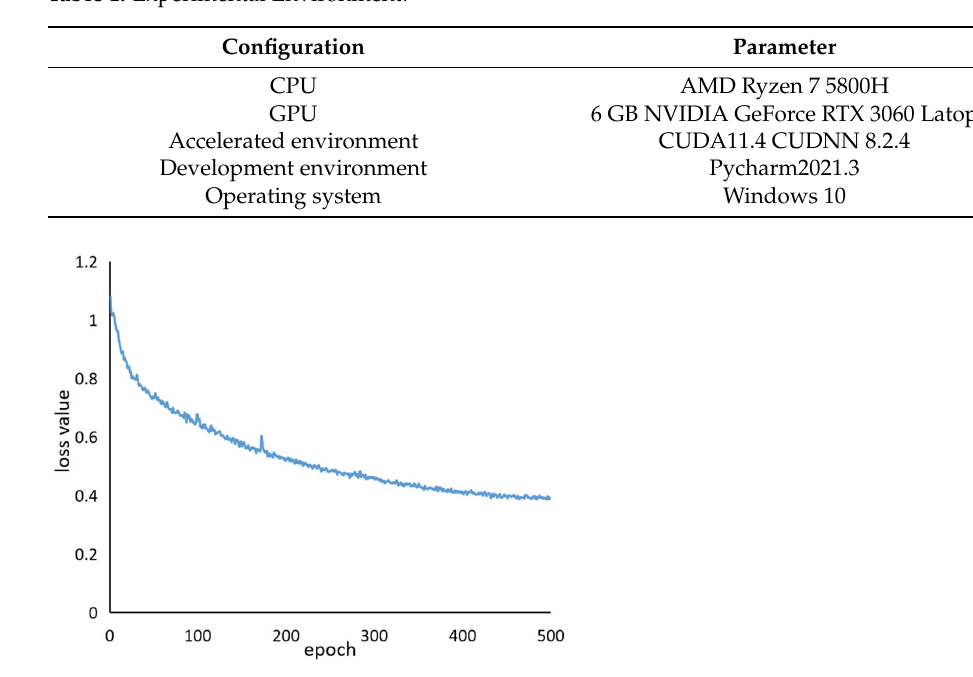
Figure 8. Training loss curve for the improved model.